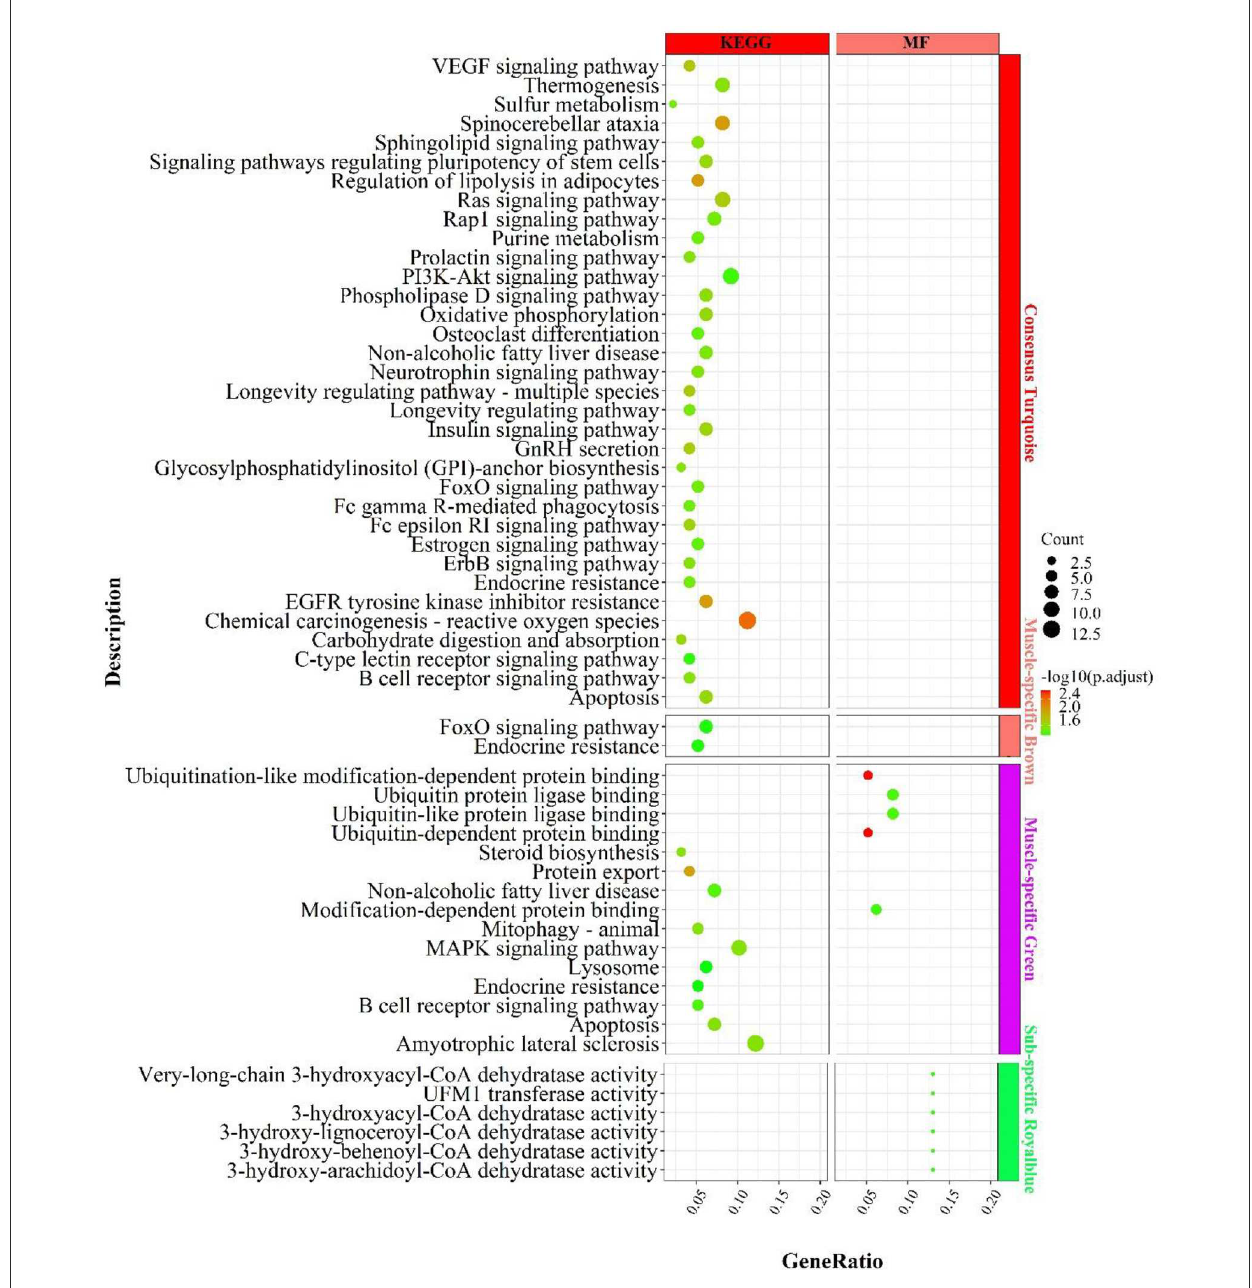
FIGURE8 Enrichment analysis for consensus or muscle-/fat-specific modules in MF regulatory axis. The dot size and color represented enriched gene numbers and the enriched significance.